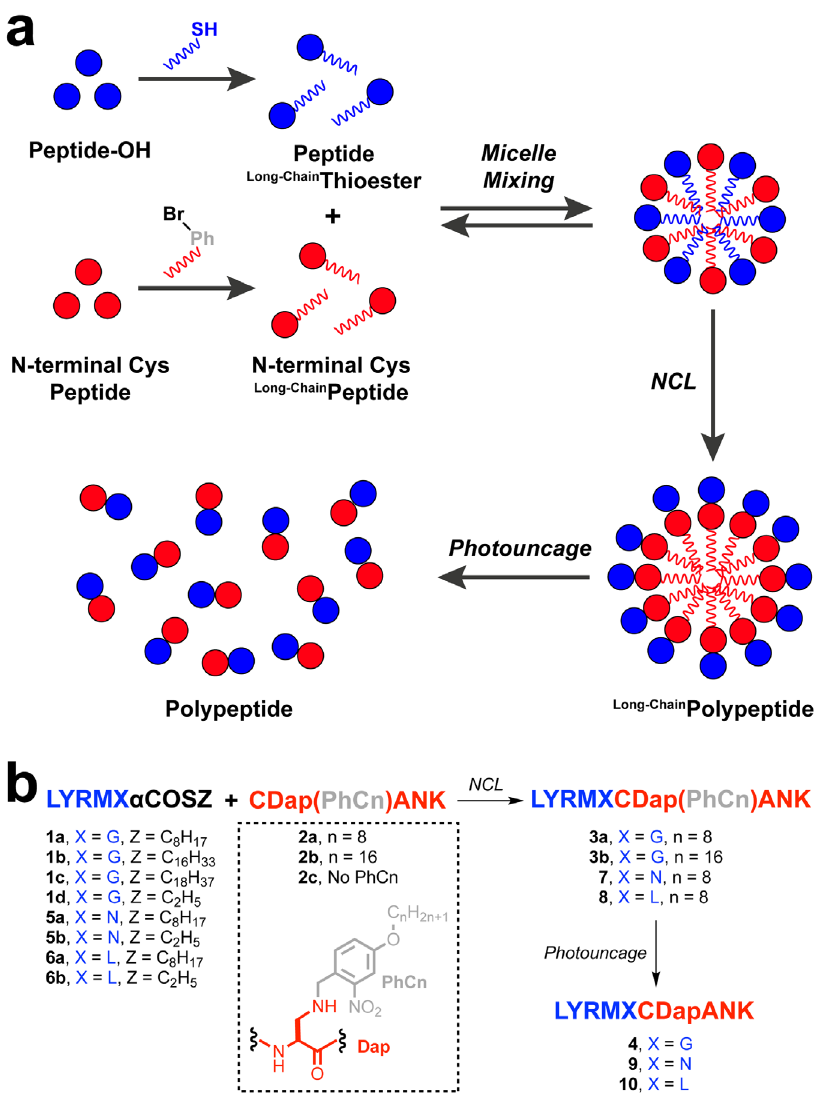
Fig. 1 Traceless lipid-facilitated acceleration of NCL. a Schematic representation of traceless lipid-facilitated NCL via micelle mixing. b NCL reaction between aliphatic alkyl peptide thioesters ( 1a – c , 5a or 6a ) and photocaged cysteine-based peptides ( 2a,b ), which yields the desired polypeptides ( 3a,b , 7 and 8 , respectively). Control reactions were performed with peptides containing short alkyl chains ( 1d , 2c , 5b , and 6b ). Subsequent photocleavage reaction of the ligated products ( 3a,b , 7 or 8 ) leads to the formation of the uncaged polypeptides ( 4 , 9 , and 10 ,